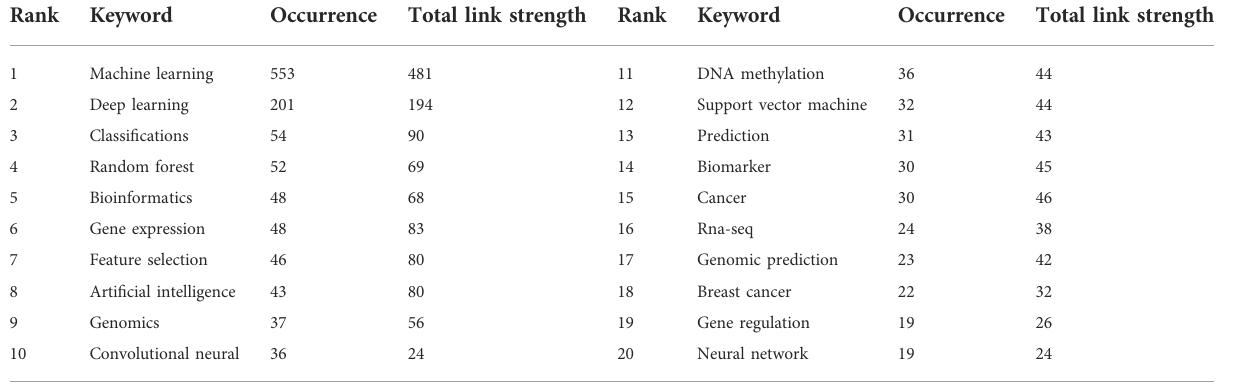
TABLE 3 Highly link strength of the top 20 occurrence